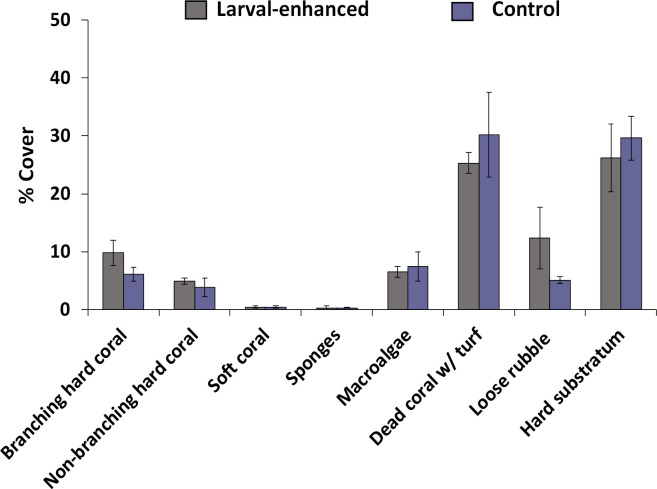
Mean percentage cover of benthic categories in larval-enhanced (N = 3) and control (N = 3) plots before the experiment.Total available area on each plot for coral settlement, which is about 8 m2, is a combination of dead hard coral and rubble. Error bars are ± SEM.